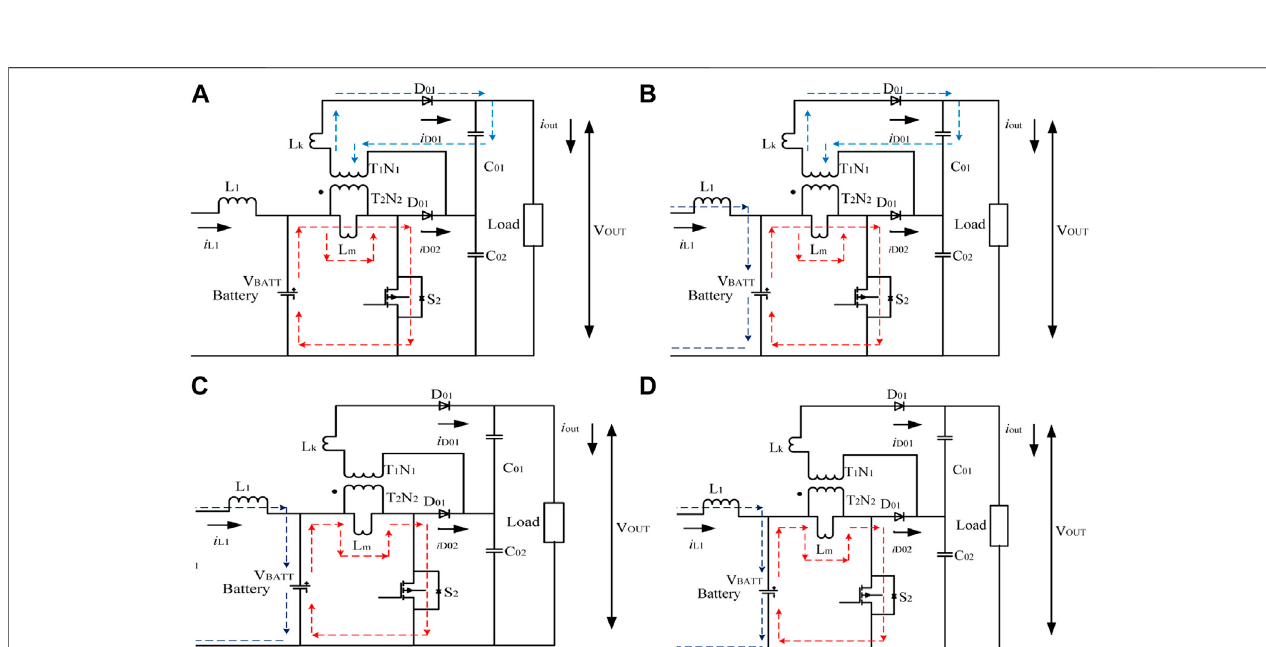
FIGURE 4 | Modes of operation of the intelligent tri-port converter for fl exible energy control and energy management in the SM.